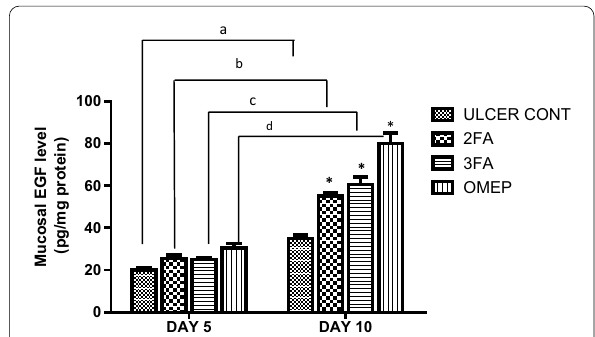
Fig. 14 Effect of folic acid supplementation on epidermal growth factor (EGF) levels in healing ulcerated gastric mucosa. (* p < 0.05 cf ulcer control; a–d p < 0.05 cf. each group on day 10). ULCER CONT Acetic acid Ulcer control, 2FA = 3FA 3 mg/kg Folic acid, OMEP =